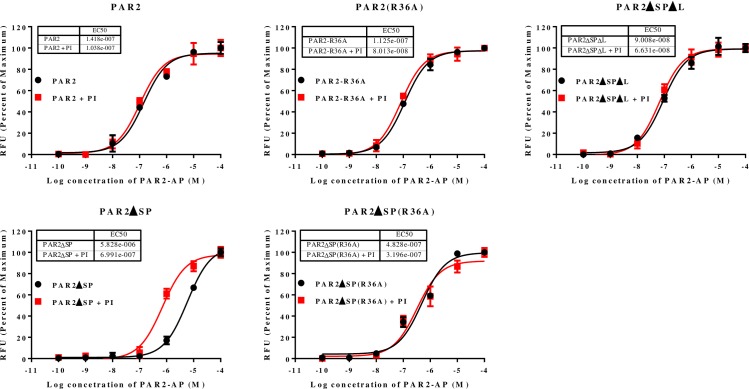
Serine protease inhibitor cocktail increases the functional expression of PAR2 without the signal peptide.HEK293 cells with par1 and par2 knocked out were used for the transient expression of various PAR2 proteins. Treatment with proteases inhibitor cocktail (PI) lowered the Emax values for all receptors with similar degrees. Protease treated samples showed about 80% response in Emax values compared with those of untreated cells. For good comparison of the EC50 values between samples treated and untreated with the protease inhibitor cocktails, the results were normalized using their Emax values and the data were expressed as the percentages of the Emax. The experiments were performed in triplicates at each data points and the results shown are mean ± sd. The experiments have been performed 3 times and very similar results have been observed. Example data is shown.